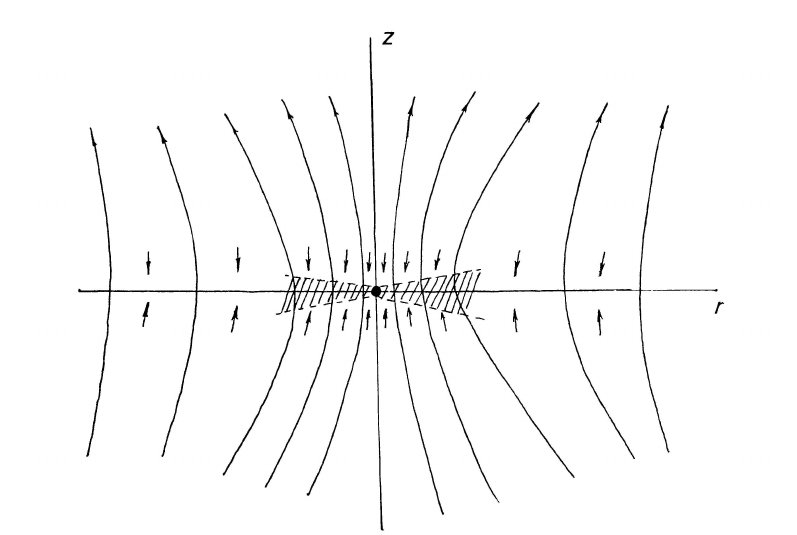
Figure 2. A qualitative picture of a stationary accretion of matter with a large scale magnetic field onto BH, Arrows indicate the direction of motion of the matter. The magnetic field far from the star is in the direction of the z -axis. The infalling matter forms a disk in the plane θ = π /2, which slowly settles to the star. In the flow region E B ∼ E kin and rotation is entirely absent from Reference